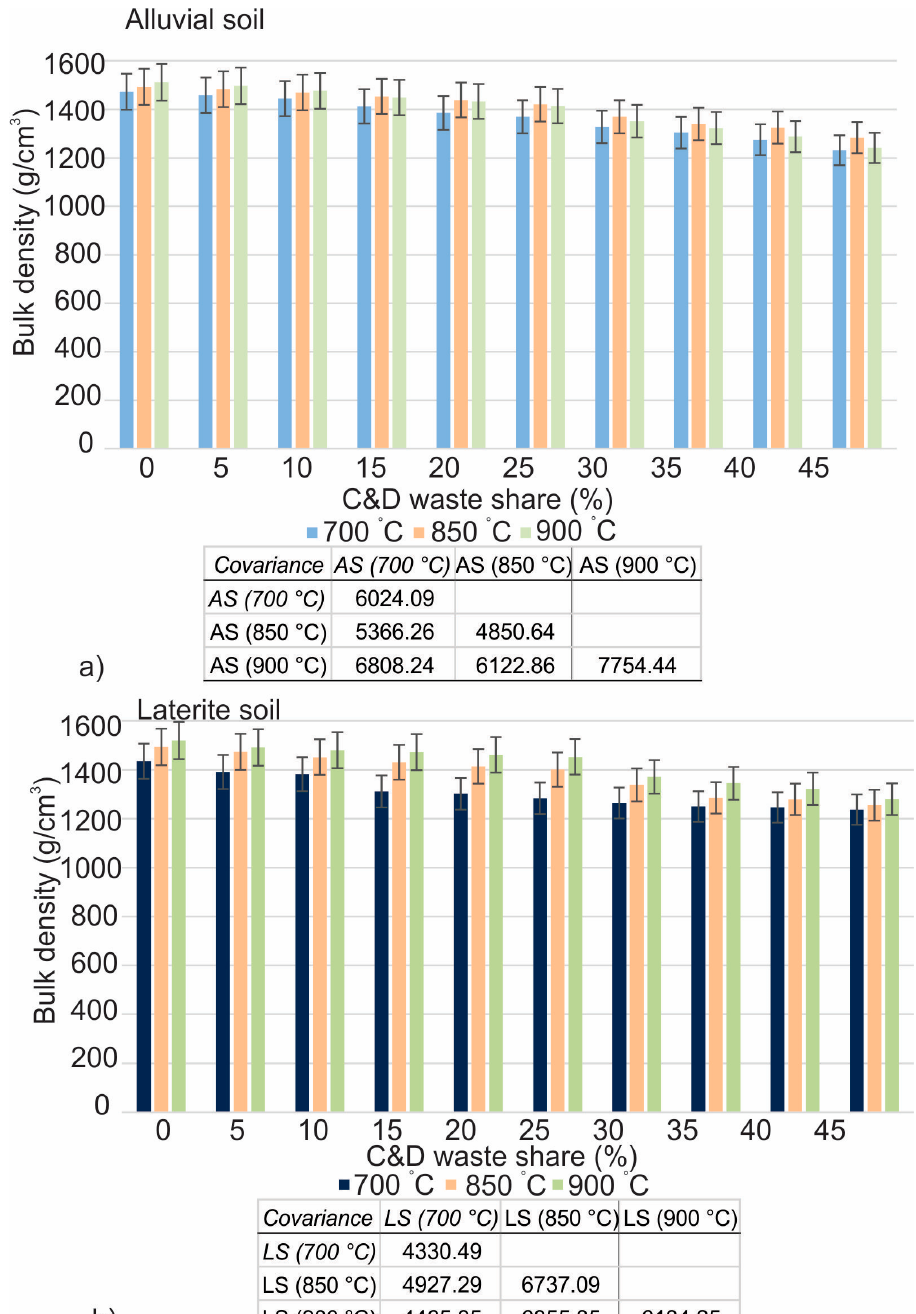
Figure 10. Bulk density of mixed C&D waste in alluvial ( a ) and laterite ( b ) soils. At 850 °C, the bulk density decreases as the mix ratio rises from 30% to 45% and is demonstrated to be 1338 g/cm 3 to 1255 g/cm 3 in laterite soil and 1369 g/cm 3 to 1283 g/cm 3 in alluvial soil. For 0% to 25% inclusion of mixed C&D waste, the decrease in bulk density on brick specimens fired at 900 °C varies from 1520 g/cm 3 to 1453 g/cm 3 in laterite soil and from 1512 g/cm 3 to 1414 g/cm 3 in alluvial soil. Incorporation of the waste into laterite soil shows bulk density variations from 1406 g/cm 3 to 1280 g/cm 3 , while in alluvial soil it ranges from 1351 g/cm 3 to 1241 g/cm 3 . At temperatures of 700 °C, 850 °C, and 900 °C, it is possible to see a decrease in the mass loss in both types of soils when mixed C&D waste is added into brick clay. The presence of more water on the clay grain, which is then evap- orated during the firing process, causes the control brick to have a greater loss on ignition, bulk density, and linear shrinkage compared to waste-added bricks. This is because con-